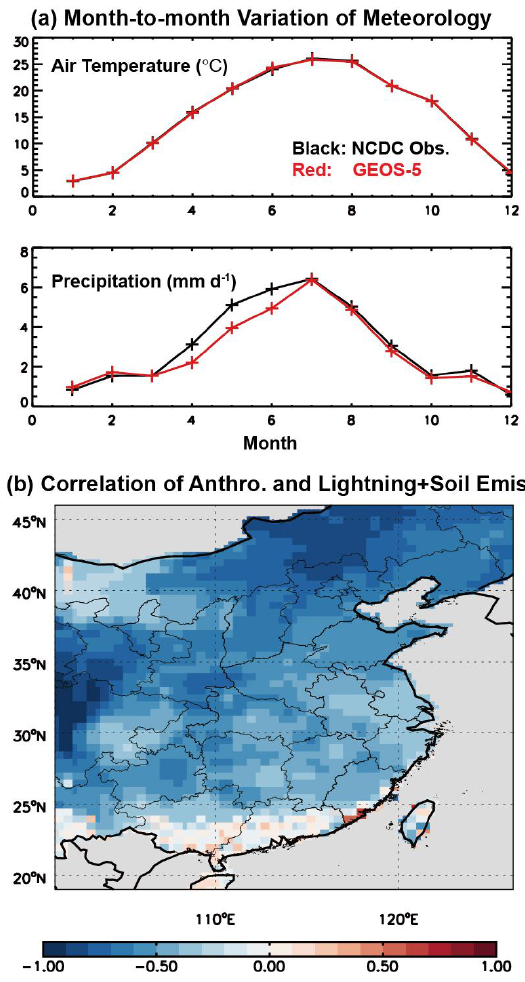
Figure 3. 2 Fig. 3. (a) Seasonal variations of monthly mean near-surface (2m) air temperature and precipitation observed from 284 meteorological stations over East China and modeled by GEOS-5. The observation data are taken from the global hourly dataset (DS3505) archived in the National Oceanic and Atmospheric Administration (NOAA) National Climatic Data Center (NCDC) (http://www7.ncdc.noaa. gov/CDO/cdo; see Lin et al., 2010b). Data from GEOS-5 are sam- pled at the meteorolgocal stations for consistency with the obser- vations. (b) Spatial distribution of the month-to-month correla- tion between a priori anthropogenic and natural (lightning+soil)